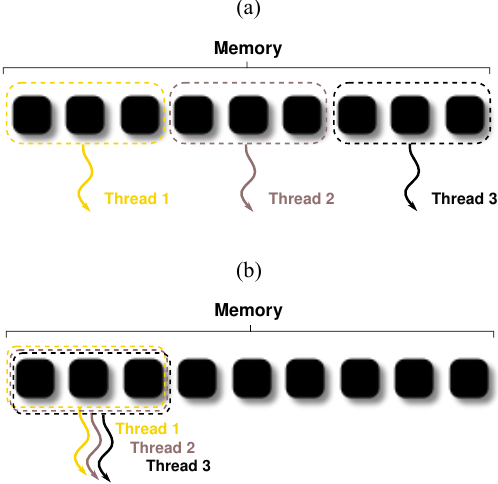
Figure 11. Illustration of strided memory access ( a ) and Coalesced memory access ( b